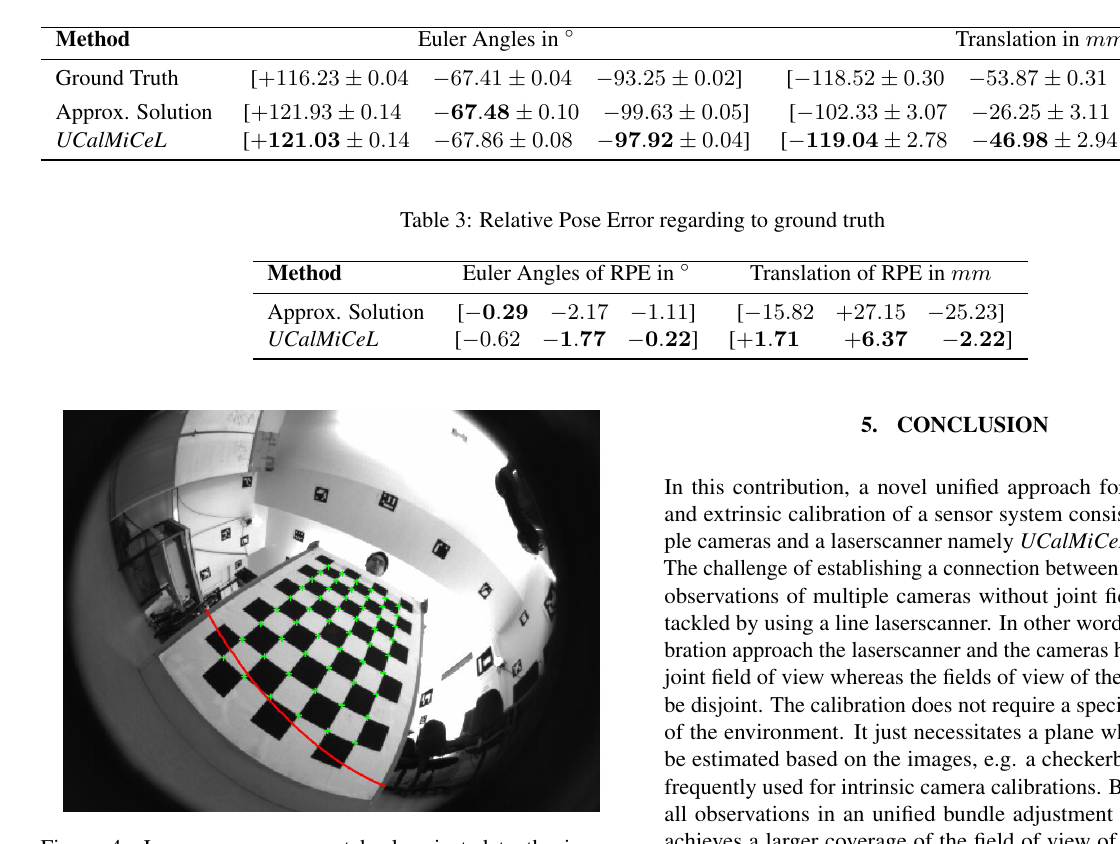
Table 2: Estimated Euler angles and translations from left to right camera